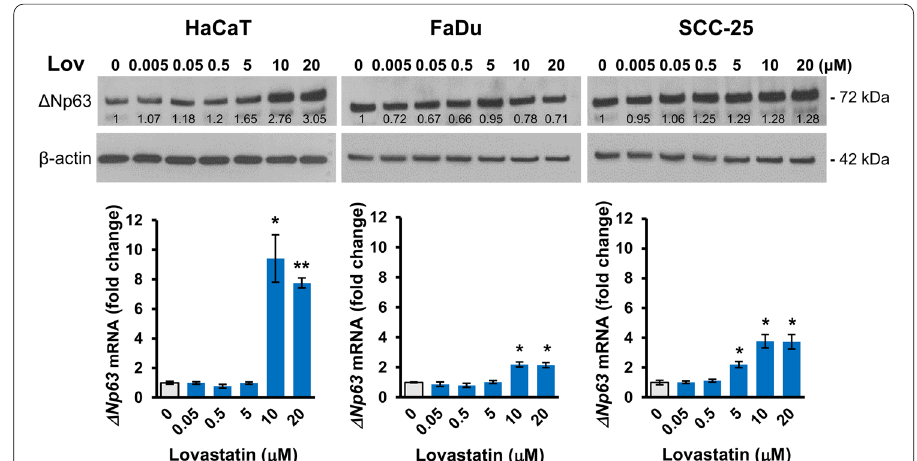
Fig. 4 Lovastatin selectively induces ΔNp63 protein and mRNA in HaCaT cells. Top panels; Representative western blots of ΔNp63 (72 kDa) and β-actin (42 kDa) as loading control for HaCaT, FaDu and SCC-25 cells treated for 24 h with the indicated concentrations of lovastatin (Lov). Relative ΔNp63 densitometry measurements normalized to β-actin are indicated, with 0 used as control. Lower panels; RT-qPCR for ΔNp63 mRNA shown as fold change after normalization to ACTB mRNA, with 0 used as control. *p < 0.05; **p < 0.01 compared to untreated